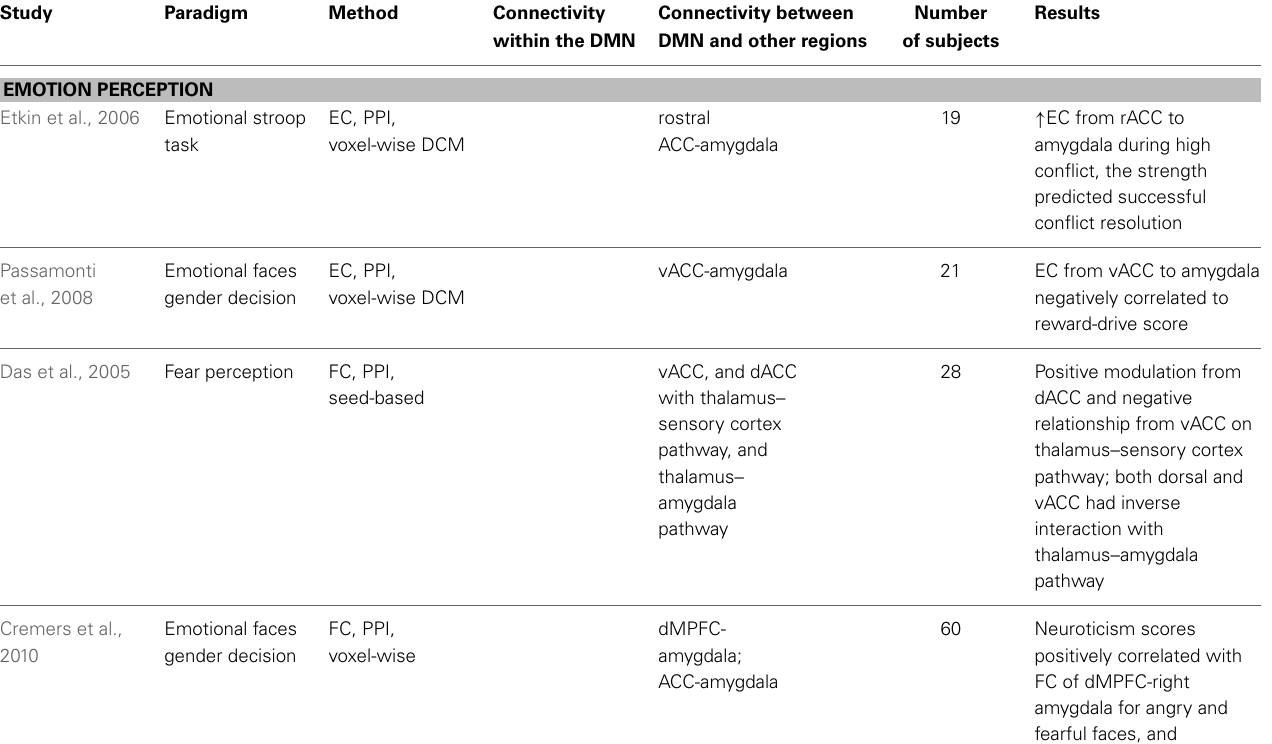
Table 1 | Brain connectivity studies on the social understanding of